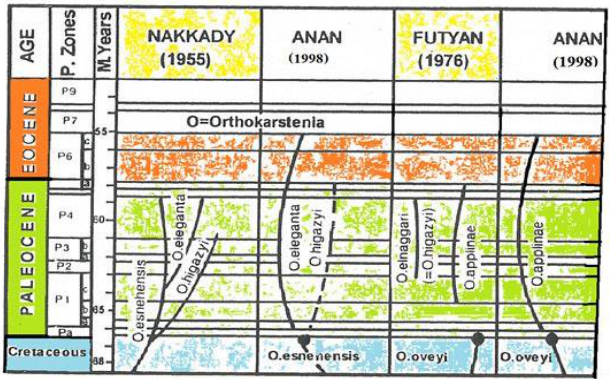
Figure 5: The phylogenitic lineages and modified stratigraphic ranges of the Cretaceous-Paleogene benthic foraminifera species of the genus Orthokarstenia by different authors. The solid lines indicate where the lineages are well defined, while a dashed line show a suggested but not well defined part of the lineage. The latter case is not probably due to ecological factors and not for stratigraphic reasons (Anan, 1998). Figure 3: Geologic map of Al Ain area including the locations of Jabal Haft, J. Malaqet and J. Mundassa, UAE. Table 1: The paleogeographic distribution of the recorded species of the genus Orthokarstenia in the Southern Tethys: 1. Tunisia, 2. Egypt,